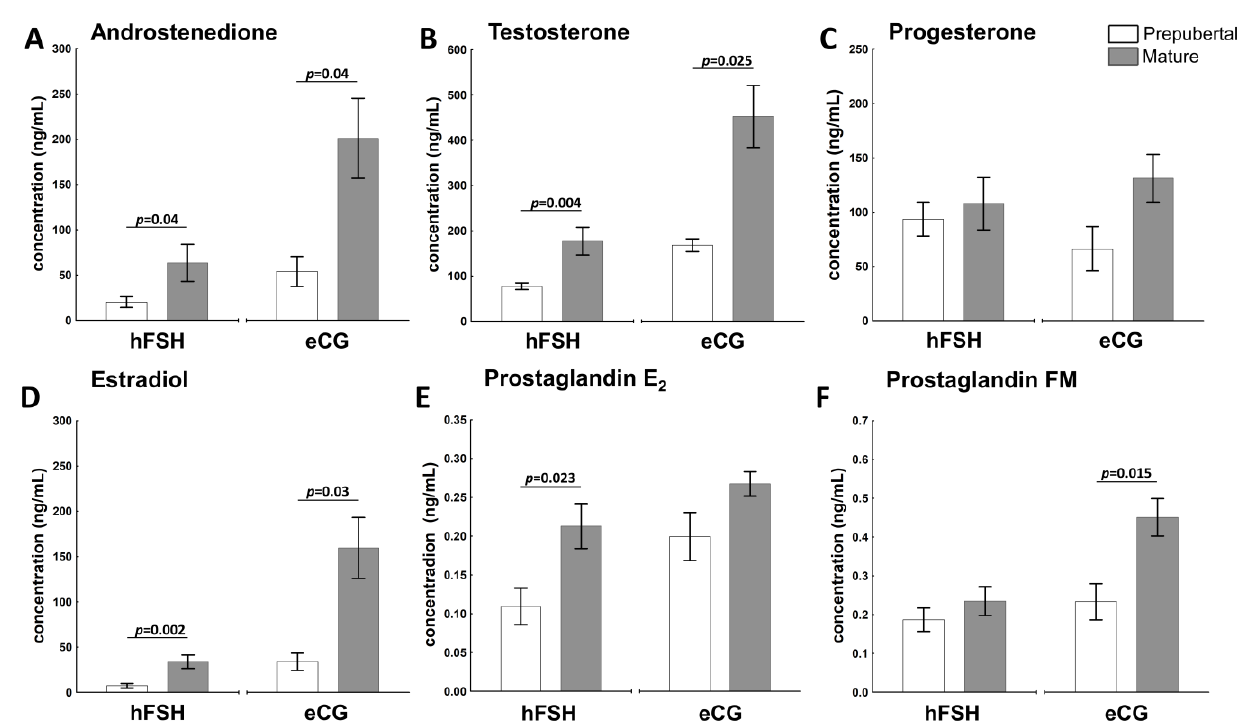
Figure 2. Hormonal milieu of the follicular fluid is affected by the sexual maturity (pre-puberty or maturity) of hFSH- and eCG-treated gilts. The follicular fluid concentration of A4 ( A ), T ( B ), P4 ( C ), E2 ( D ), PGE2, ( E ) and PGFM ( F ) is shown for prepubertal and mature gilts. Data are presented as mean ± SEM (n = 6 per group ). Data were analyzed using Student’s t -test for each hormonal treatment. Line with a p -value denotes significant differences between prepubertal and mature gilts.